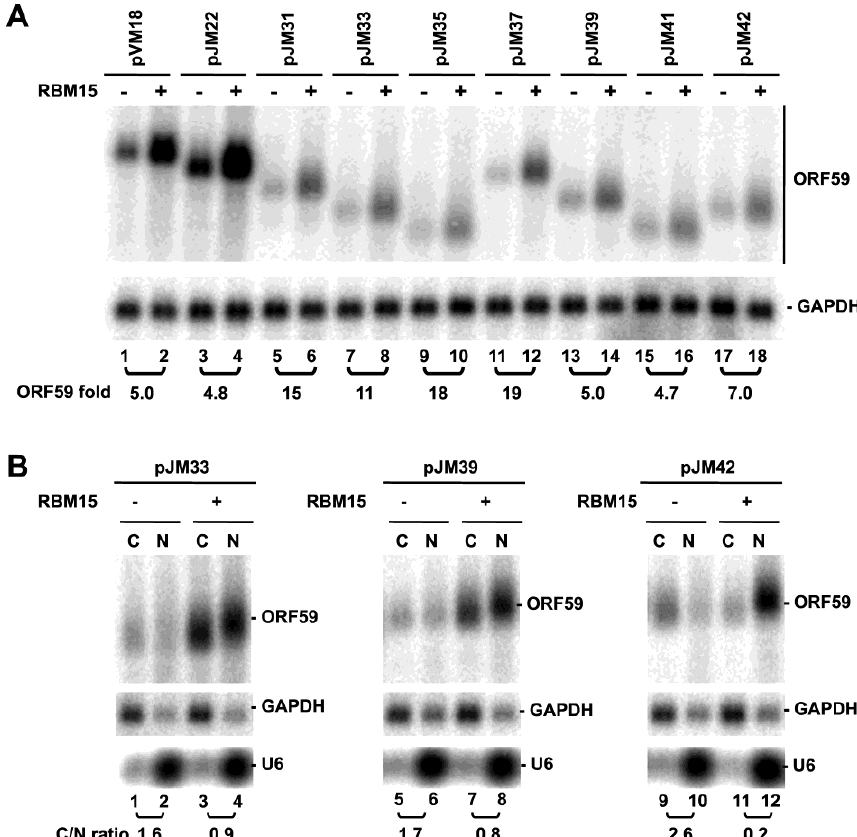
Figure 5. RBM15-mediated RNA accumulation of wt and mt ORF59 in the absence of ORF57. ( A ) Total RNA from HEK293 cells transfected with each of ORF59 constructs described in Figure 1A in the presence (+) or absence (−) of RBM15 were analyzed by Northern blot analysis as described in Figure 1B for ORF59 RNA expression using antisense oligo probe oVM158 for pVM18, pJM22, pJM31, pJM33 and pJM35 or antisense oligo probe oJM65 for pJM37, pJM39, pJM41 and pJM42. The same membrane was re-probed separately with GAPDH-specific probe for sample loading. ( B ) RBM15 promotes ORF59 expression and nuclear accumulation of the hyperpolyadenylated ORF59 RNA. Fractionated cytoplasmic (C) and nuclear (N) RNA from HEK293 cells cotransfected with each